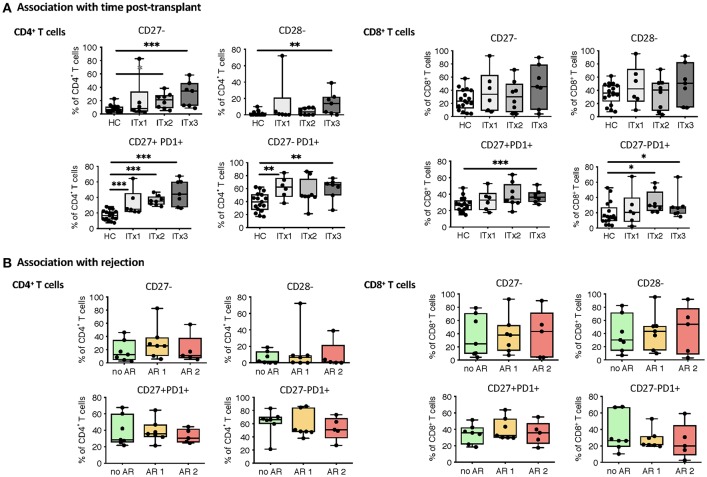
Analysis of T cell senescence and exhaustion markers. Boxplots of proportions (median and minimum to maximum) of CD27−, CD28− as well as PD1 expressing subpopulations of CD4+ and CD8+ T cells in whole blood patient samples and healthy control samples were determined by flow cytometry and plotted according to time post-transplant (A: ITx = 0–4 years, n = 7; ITx = 4–10 years, n = 8; ITx > 10 years, n = 6) or occurrence of rejection episodes (B: no AR = no rejection, n = 7; AR1 = acute humoral/mixed rejection, n = 7; and AR2 = acute cellular rejection, n = 5). Statistical analysis was done using a Kruskal-Wallis-Test and Conover post-hoc test. *p < 0.05, **p < 0.01, ***p < 0.001.